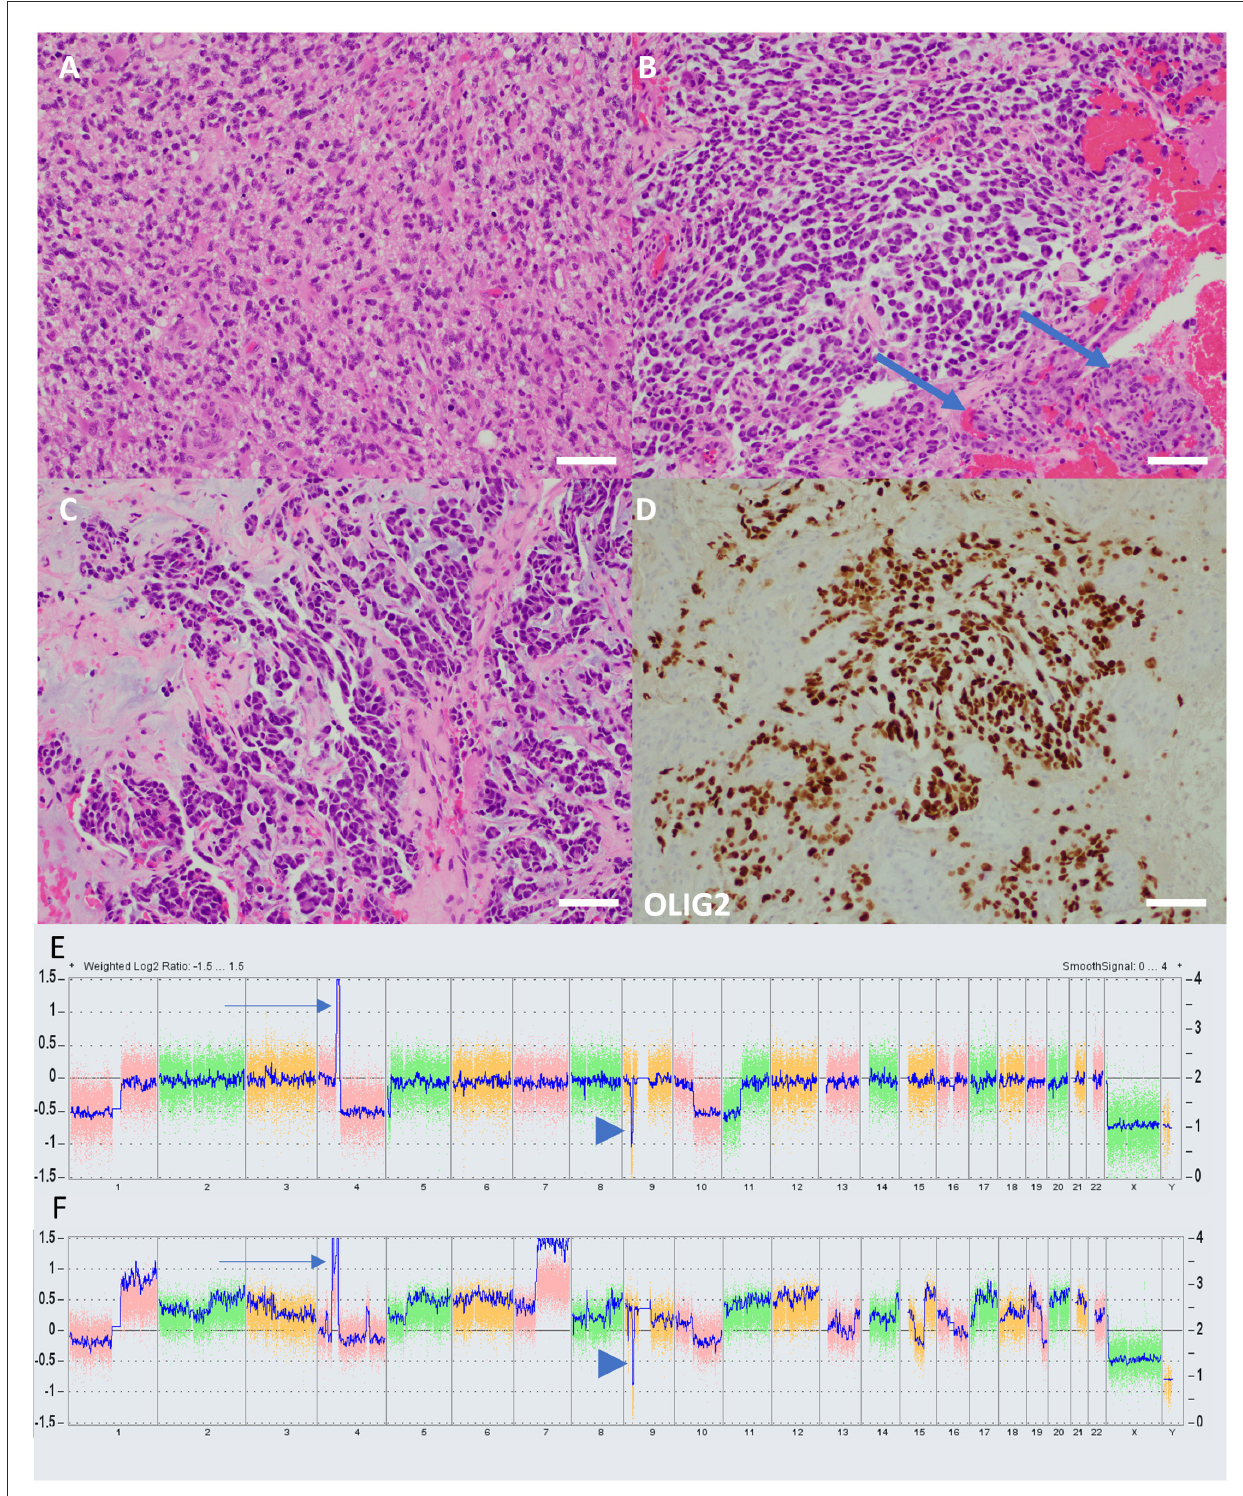
FIGURE2 Histology and molecular characteristics of cases. (A) The H&E-stained section from case 1 demonstrates histologic features of a typical high-grade diffuse glial neoplasm, including frequent mitoses and anaplasia. Vascular proliferation and necrosis, grading features diagnostic of GB, were present but not shown. (B) In contrast, an H&E-stained section from case 2 demonstrates a tumor not immediately reminiscent of glioma, with a prominent myxoid background and cells which take on an epithelioid appearance. Florid vascular proliferation is present (arrows). (C) In case 2, the tumor has almost glandular architecture, which is suggestive of metastatic carcinoma. (D) An immunostain for OLIG-2, a marker of glial lineage, nonetheless confirms that the tumor in case 2 is, indeed, glioma. The pathologist diagnosing case 2, given the uncharacteristic appearance of the tumor, felt it necessary to run several confirmatory immunohistochemical markers, including cytokeratins, to rule out entities such as metastatic carcinoma and